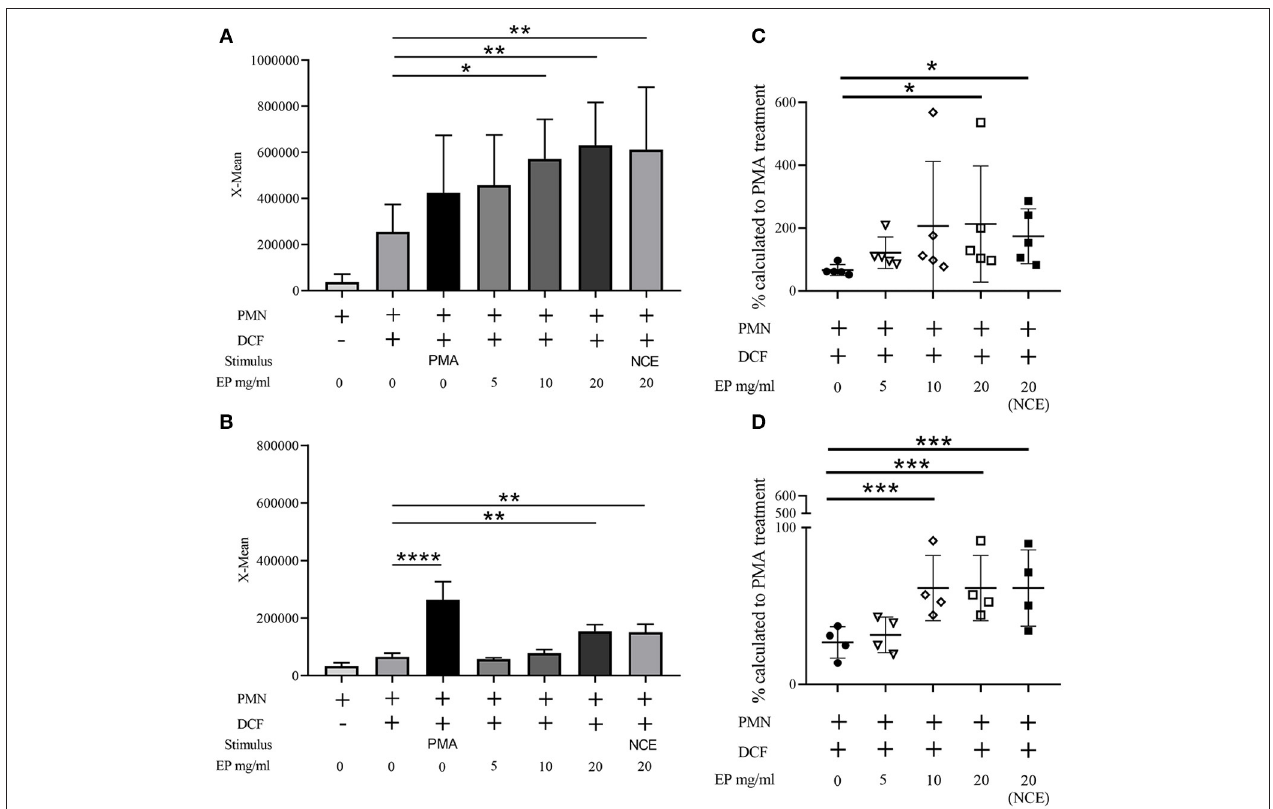
FIGURE 6 | Effect of ethanol precipitate (EP) on oxidative burst (ROS production) of human and bovine granulocytes. Mean fluorescence intensity (X-mean) of ROS was measured by FACS (BL-1) using DCF fluorescence probe (A) n = 5; (B) n = 4. Phorbol 12-myristate 13-acetate (PMA) was used as a positive control to induce ROS. EP significantly induces ROS production in human granulocytes (A) and bovine granulocytes (B) compared to unstimulated cells (cell + DCF). Additionally, the relative value to the PMA stimulated cells was calculated and is presented as percentage (C,D) . Each dot represents one experiment. All data are shown as means ± SD. Statistical analysis was conducted with one-way ANOVA repeated measurement followed by Dunnett’s multiple comparisons test (A,B,D) or in the case of non-normal distributed data by Friedman multiple comparisons test (C) to unstimulated cells. * P < 0.05, ** P < 0.01, *** P < 0.001, and **** P < 0.0001 were considered